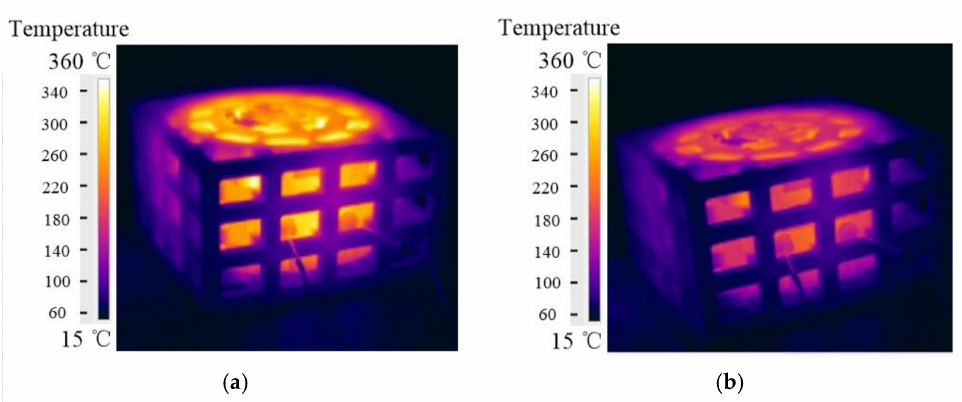
Figure 11. Infrared images of the lattice sand mold during the casting process: at ( a ) 1000 s; and ( b ) 5000